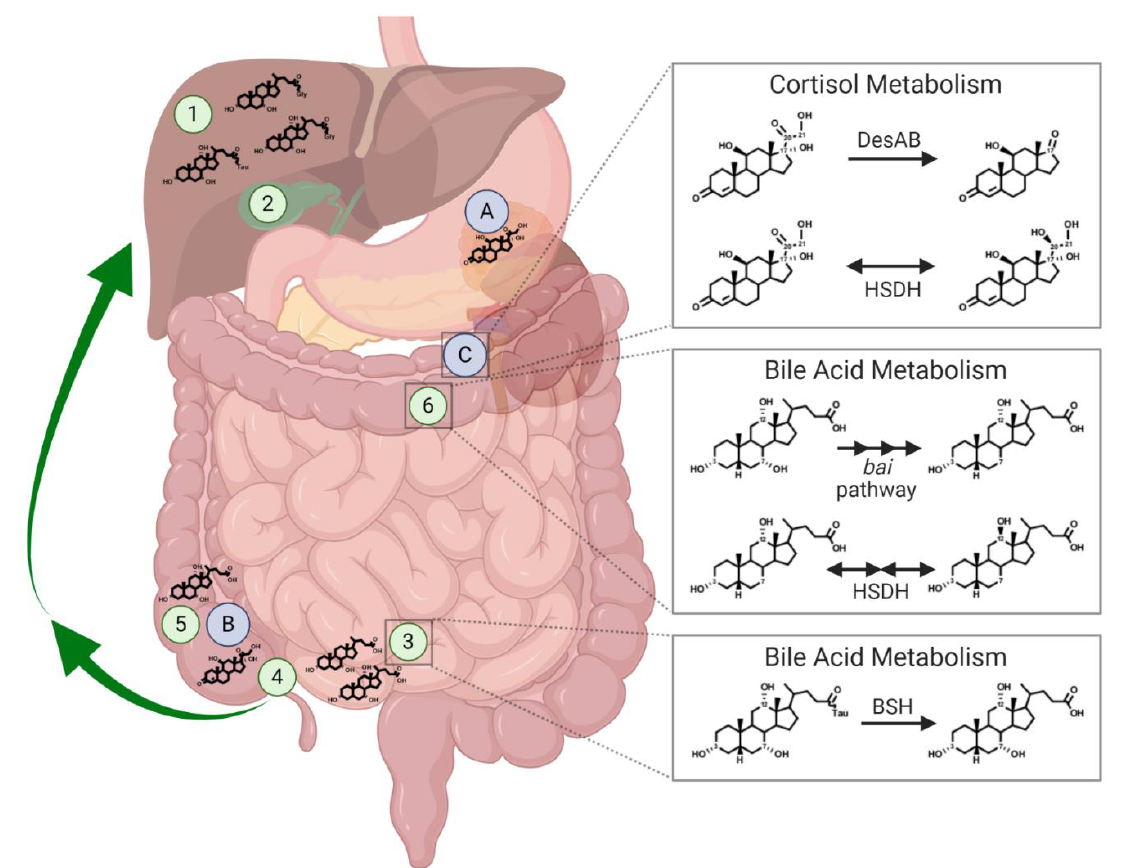
Figure 2. Synthesis and microbial metabolism of bile acids and cortisol. (1) The bile acids (BAs) cholic acid (CA) and chenodeoxycholic acid (CDCA) are synthesized and conjugated to glycine (Gly) or taurine (Tau) in the liver. (2) They are then stored in the gallbladder until they are released in response to a meal. (3) Microbial deconjugation of amino acids, catalyzed by bile salt hydrolase (BSH), primarily occurs in the small intestine. (4) BAs are taken up in the terminal ileum and undergo enterohepatic circulation back to the liver indicated by green arrows. (5) About 5% of BAs are not recycled and proceed to the colon. (6) Gut microbiota residing in the colon can 7 α -dehydroxylate CA or CDCA to secondary BAs in a pathway encoded by the BA-inducible ( bai ) operon. Microbial hydroxysteroid dehydrogenases (HSDHs) interconvert BA hydroxyl groups between the α - and β -conformations through an oxo-intermediate. (A) Cortisol is synthesized in the adrenal glands. (B) Cortisol and its derivatives are principally excreted in urine; however, low levels are secreted in bile and enter the gut. (C) In the gut, cortisol can be side-chain cleaved by microbiota encoding steroid-17,20-desmolase (DesAB) or reduced to 20 α - or 20 β -dihydrocortisol by